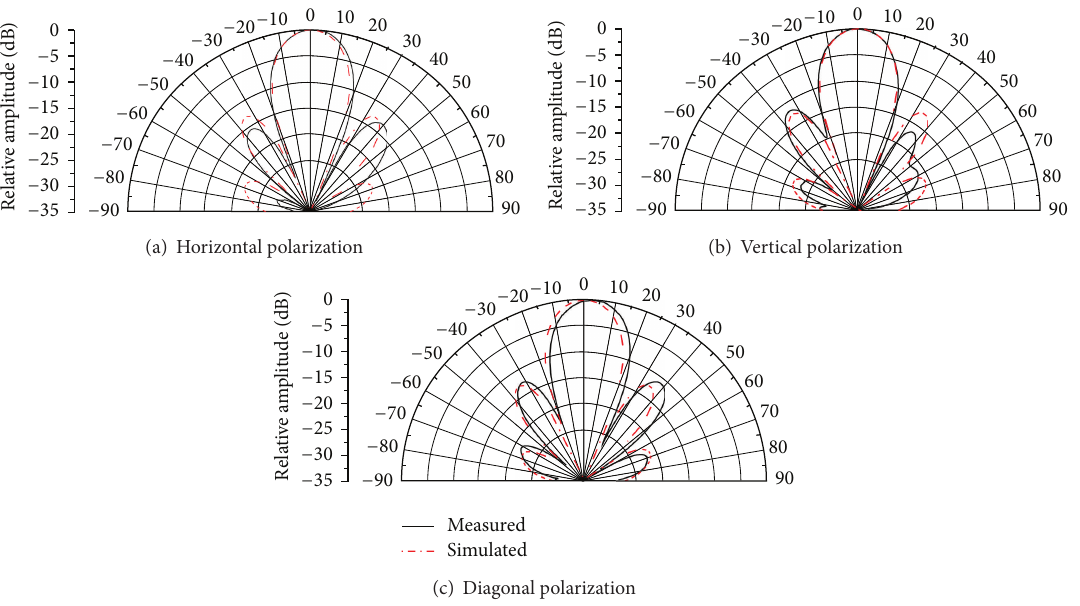
Figure 16: The polarization tracking patterns measured at 12.5 GHz with beam scanned to 0 ∘